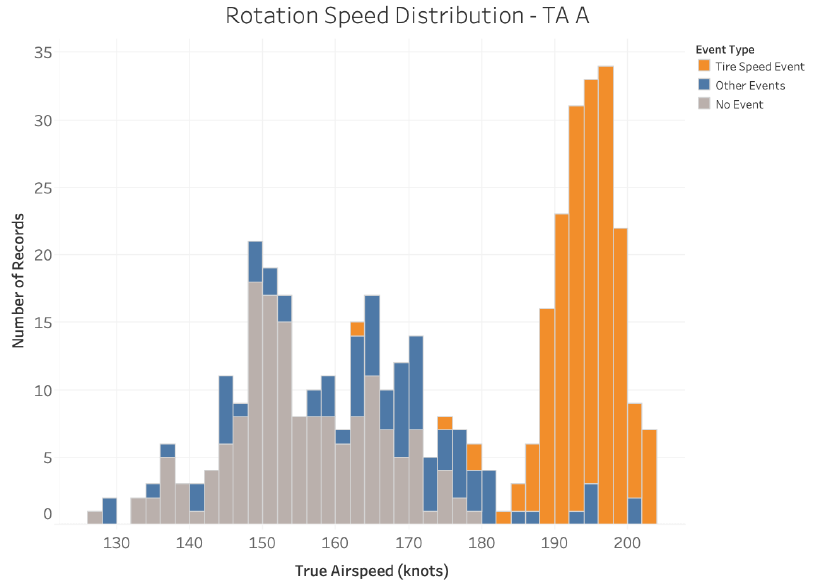
Figure 8. Airspeed distribution for twin-aisle airframe A